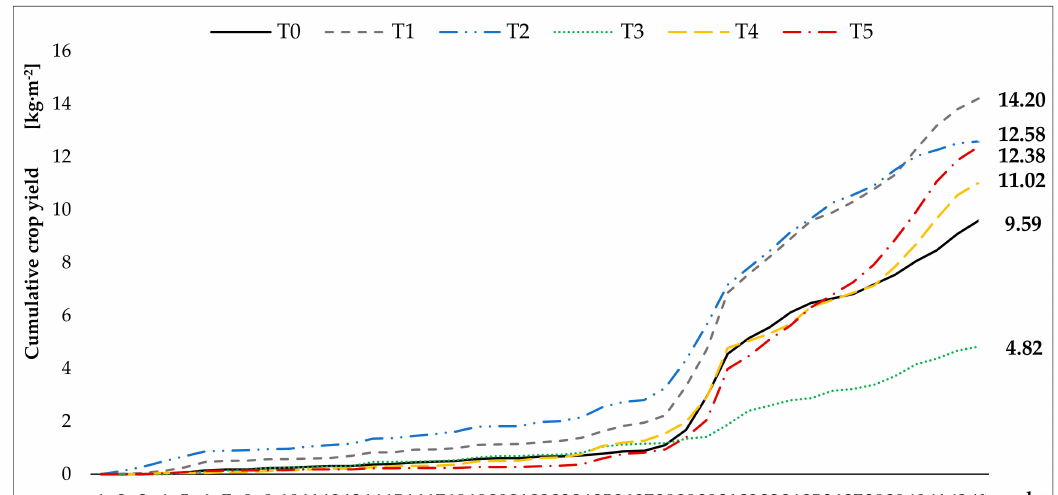
Figure 3. Cumulative crop yield of the five cultivars on 43 weeks in (kg · m − 2 ), T0 ( (cid:4) ): Intenzza; T1 ( (cid:4) ): Grafted Intenzza; T2 ( (cid:4) ): Sweet sense; T3 ( (cid:4) ): Vitale; T4 ( (cid:4) ): Caballero; T5 ( (cid:4) ): Alicia planted under greenhouse.